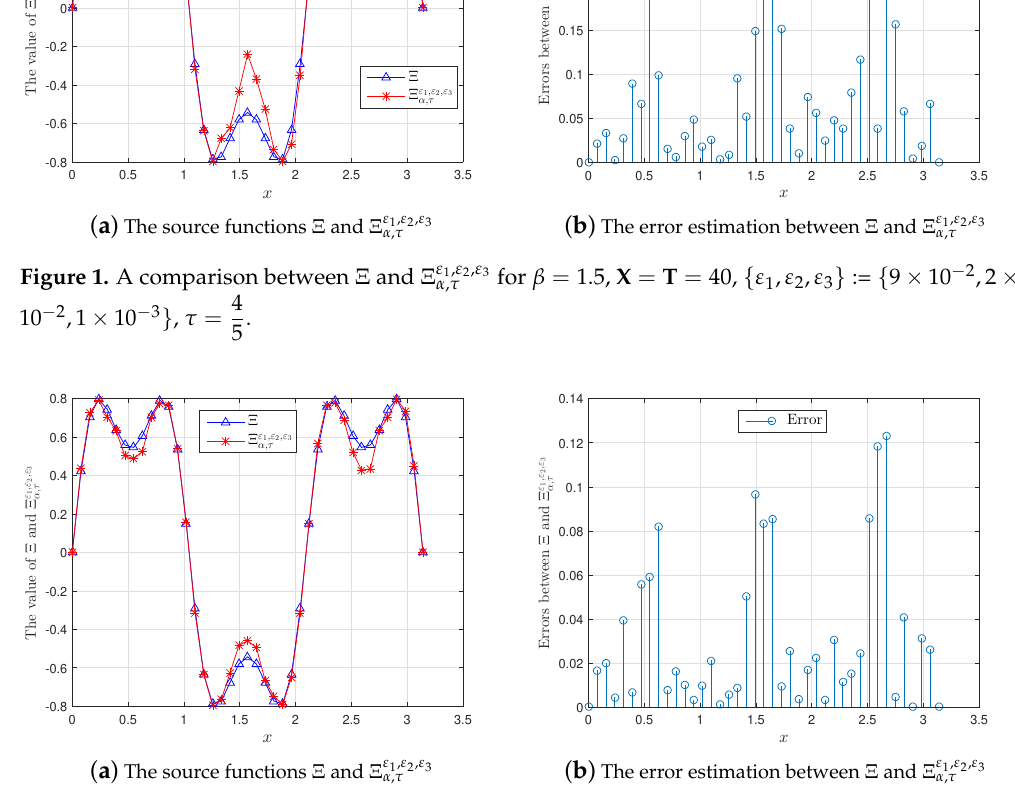
( b ) The error estimation between Ξ and Ξ ε 1 , ε 2 , ε 3